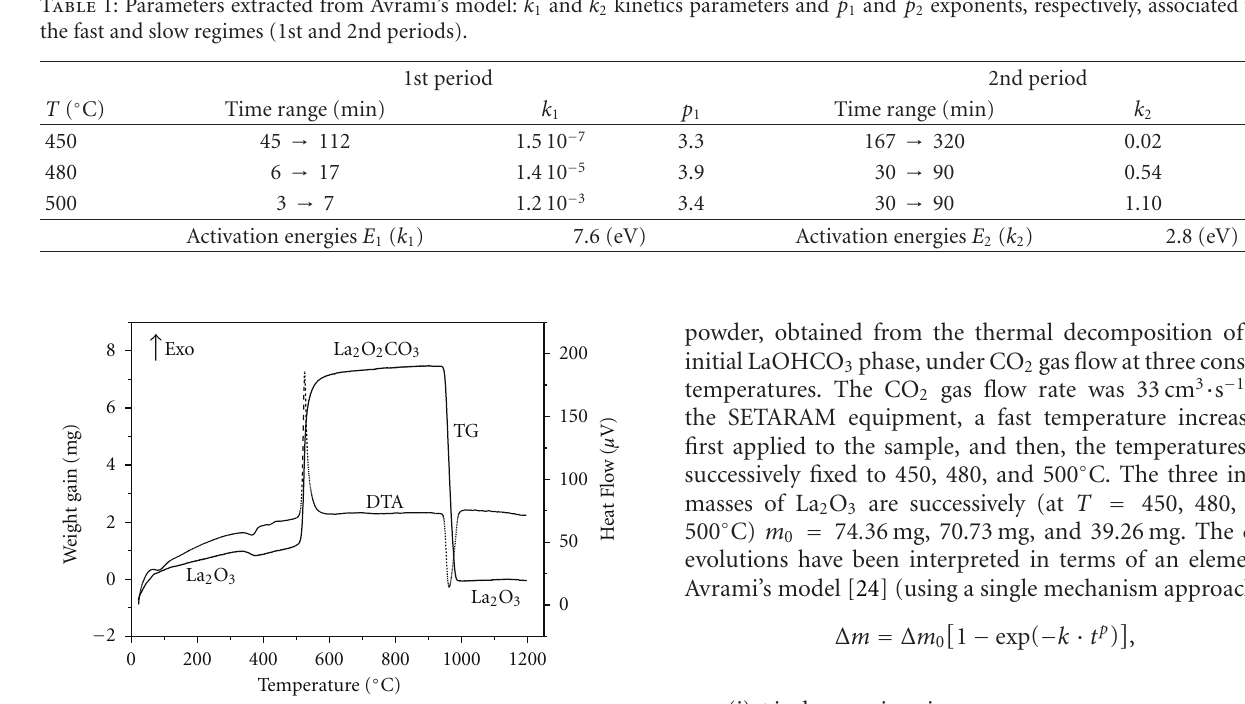
of the monoclinic La 2 O 2 CO 3 phase heated at 520 ◦ C under CO 2 flow, during 3 hours. The refined cell parameters are a = 0 . 4073 ± 0 . 0003 nm; b = 1 . 3503 ± 0 . 0008 nm; c = 0 . 4079 ± 0 . 0005 nm; β = 90 . 89 ◦ . In the pattern, a weak trace of the hexagonal phase (noted as ∗ ) is